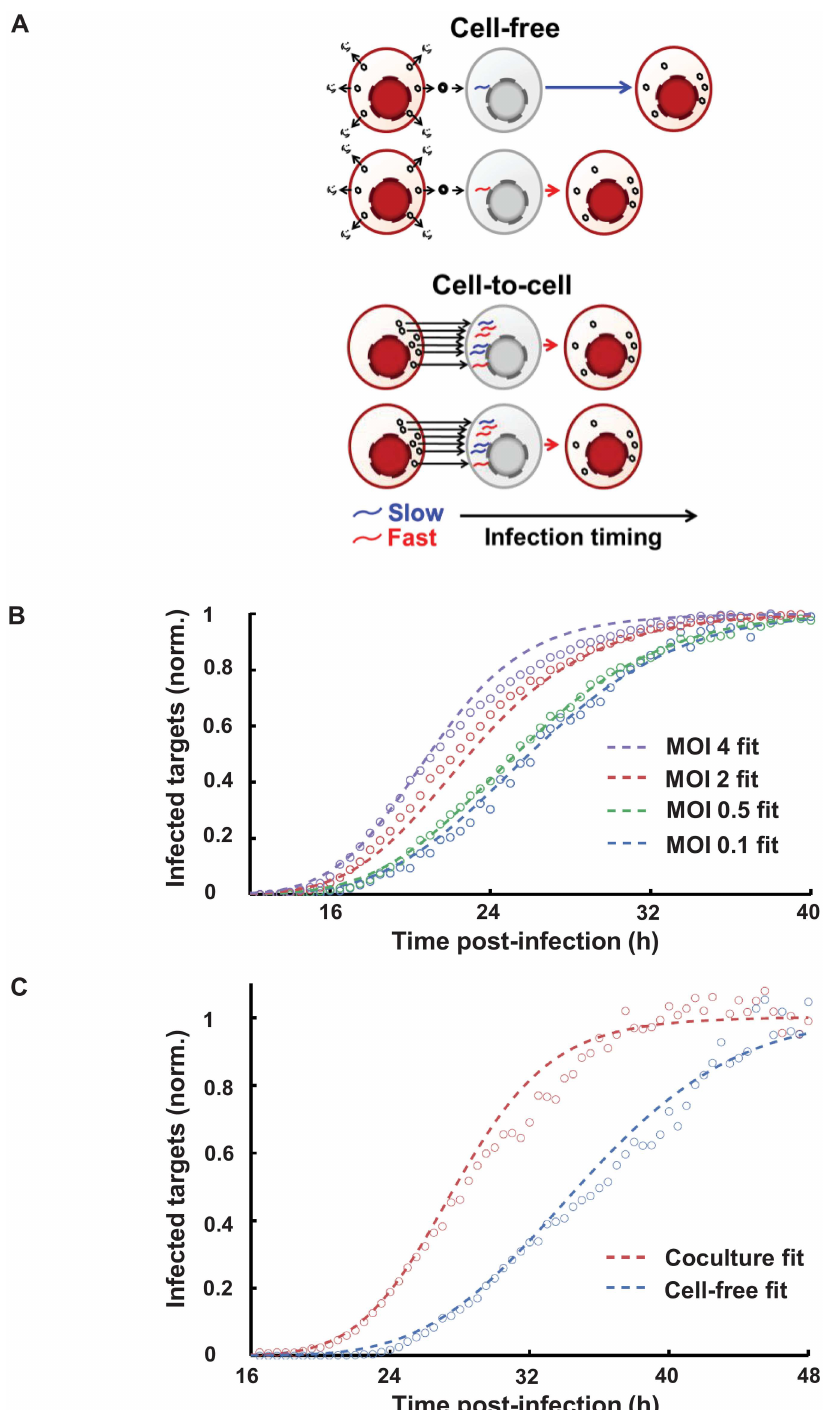
Fig 4. Modelling faster onset of HIV gene expression by multiple infections per cell. ( A ) Proposed probabilistic mechanism for the more rapid onset of HIV gene expression. ( B ) Simulationof cell-free infection times at different MOI by random draws from a Gamma distribution parametrizing the best fit cell-free infection times of single virion infections. Circles are experimental data from Fig 3A, dashed lines represent the simulation results for MOI of 0.1 (blue), 0.5 (green), 2 (red), and 4 (purple). Fitted means ± std of infection times were 26.4 ± 5.2, 25.2 ± 5.1, 22.7 ± 4.8, and 21.9 ± 4.9 hours. ( C ) Fit of coculture versus cell-free